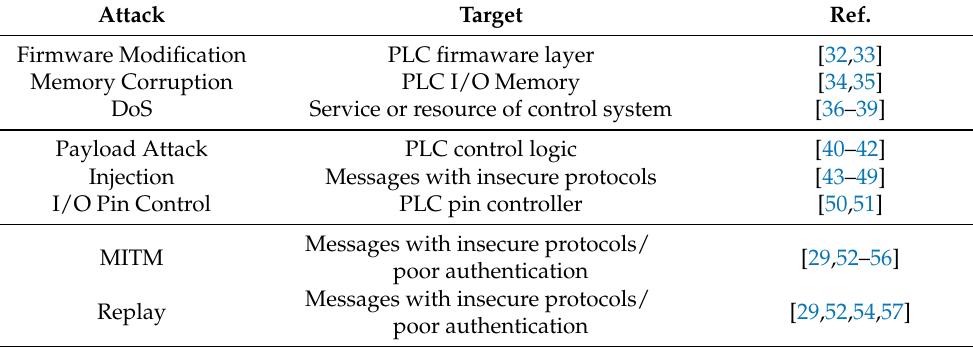
Figure 4. Classification of attacks in PLC-based control systems. Table 1. Main findings in attack